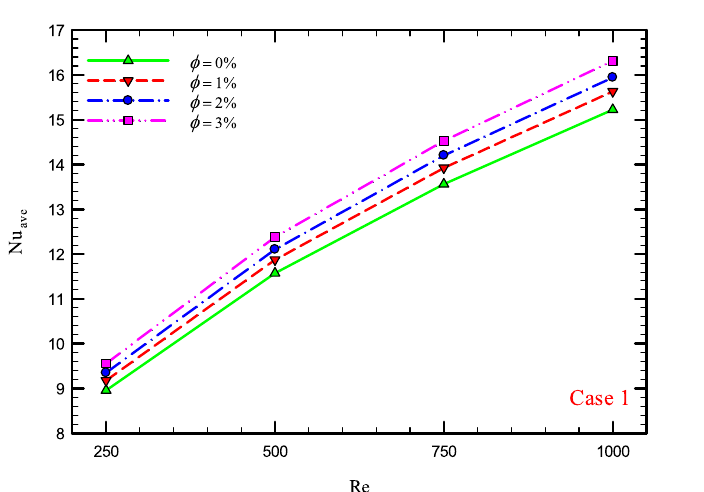
Figure 9. Nu ave versus Re for Case 1.